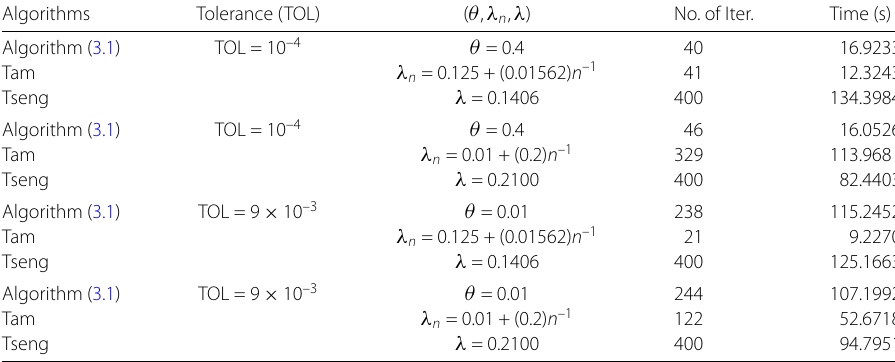
Table 1 Computational Results for Example